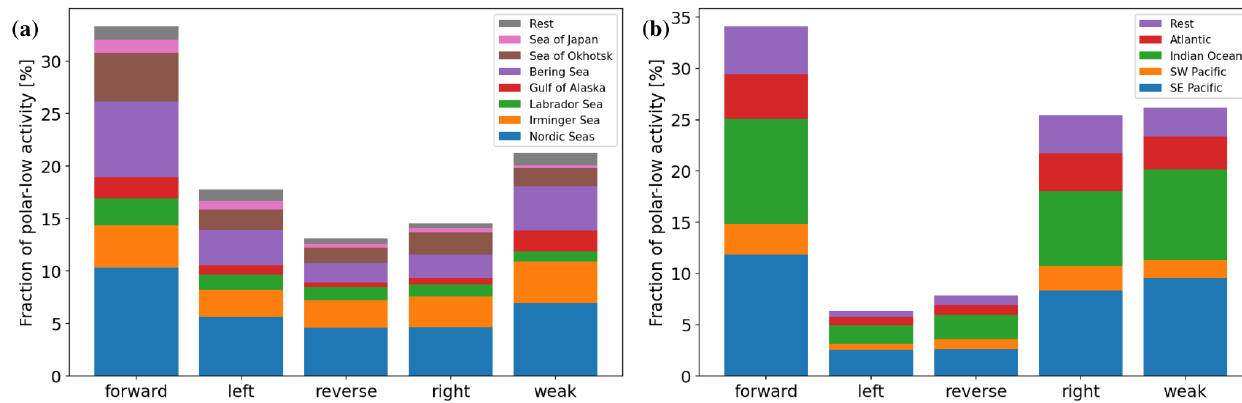
Figure 8. Distribution of the different shear categories in the (a) Northern Hemisphere and (b) Southern Hemisphere.